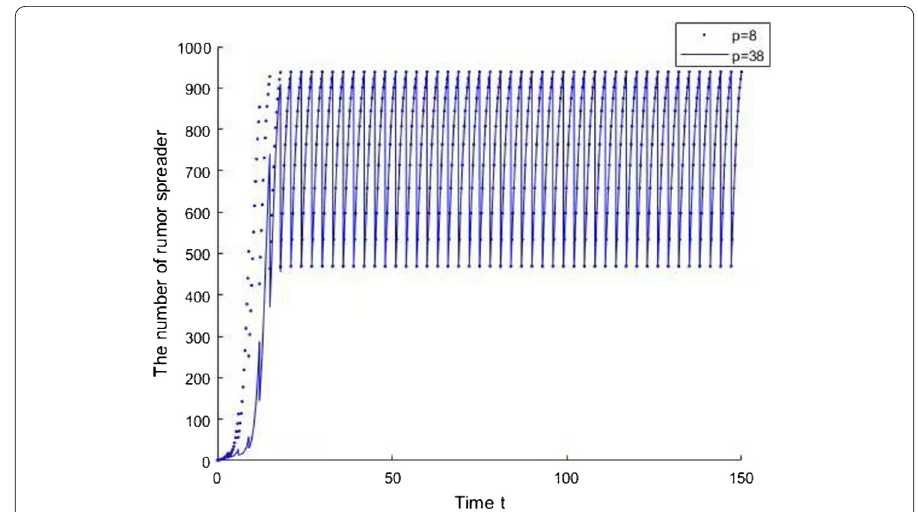
Figure 7 When p < p thr , the evolution graph with different p of y ( t ) show a periodic solution